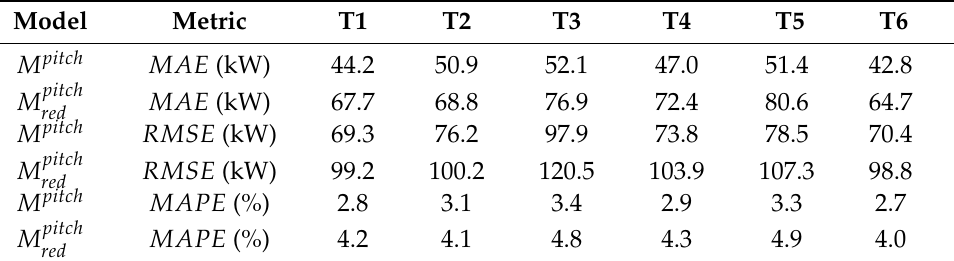
Table 5. Results of the models validation for the blade pitch-power curve in Region 2 1 / 2 :